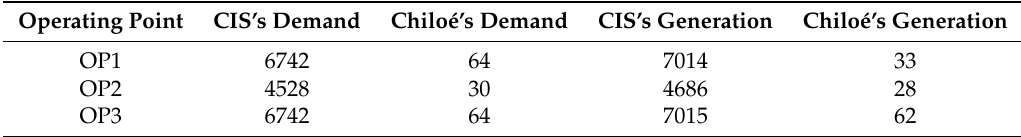
Table 4. Characteristics of the operating points (OPs) in